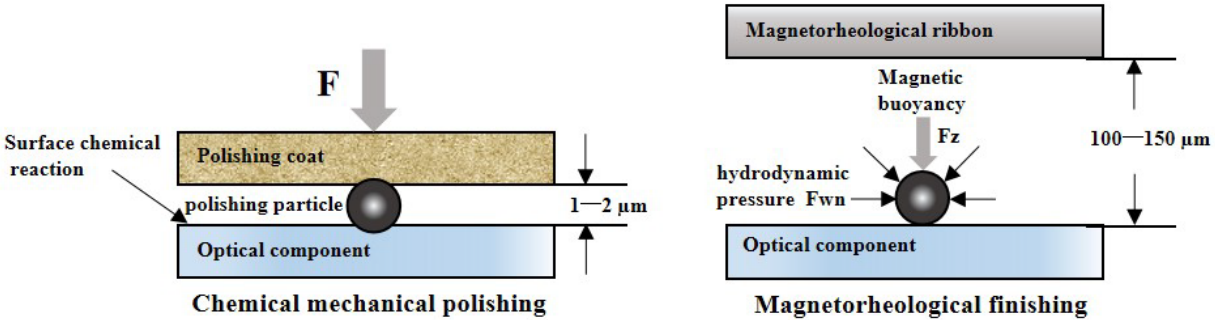
Figure 6. Interaction between polishing particles and optical elements in chemical mechanical polishing and magnetorheological polishing.